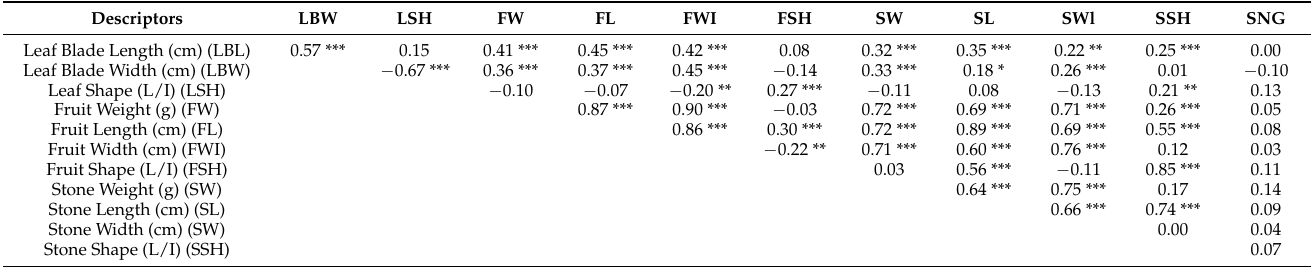
Table 3. Correlation between 12 morphological quantitative traits based on individual tree averages. The values higher than 0.7 indicate a strong correlation and are reported in